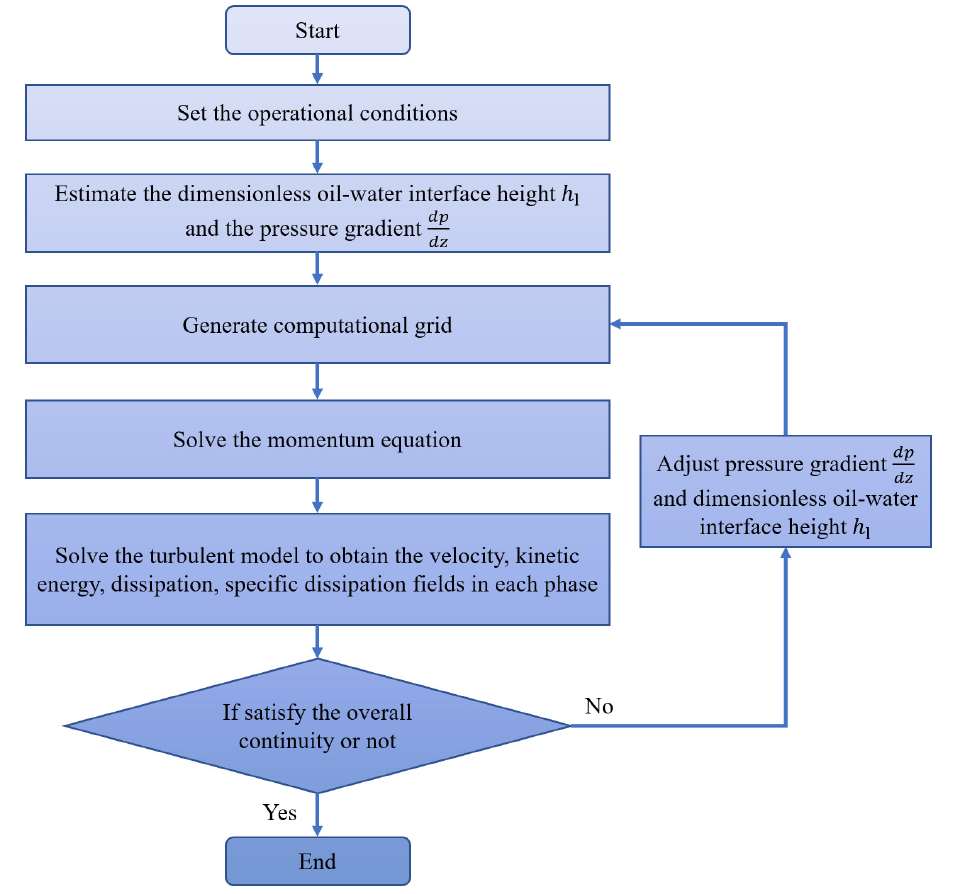
Figure 3. Flow chart of numerical solution.